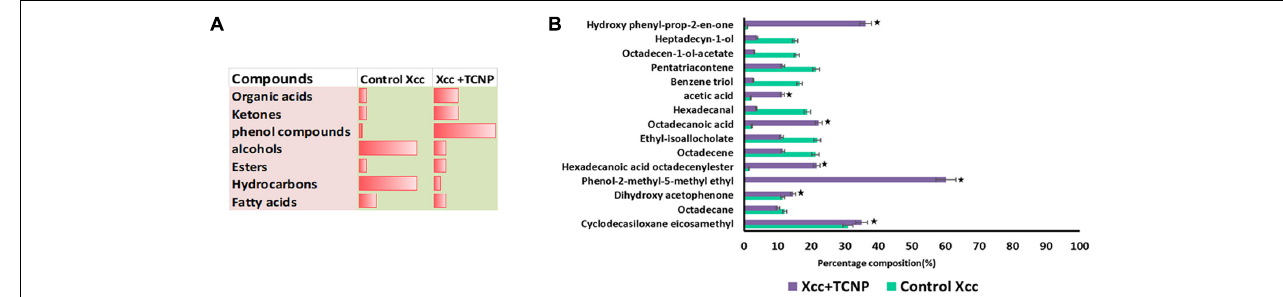
FIGURE 6 | VOC profiling by HS-SPME/GCMS (A) Proportion of chemical compounds detected in control untreated Xcc cells and TCNP treated cells. (B) Clustered bar plot with changes in the volatile profiles of control untreated Xcc cells and TCNP treated cells. Values are mean ± SD of three independent experiments, each performed in triplicates and considered statistically significant when * p <